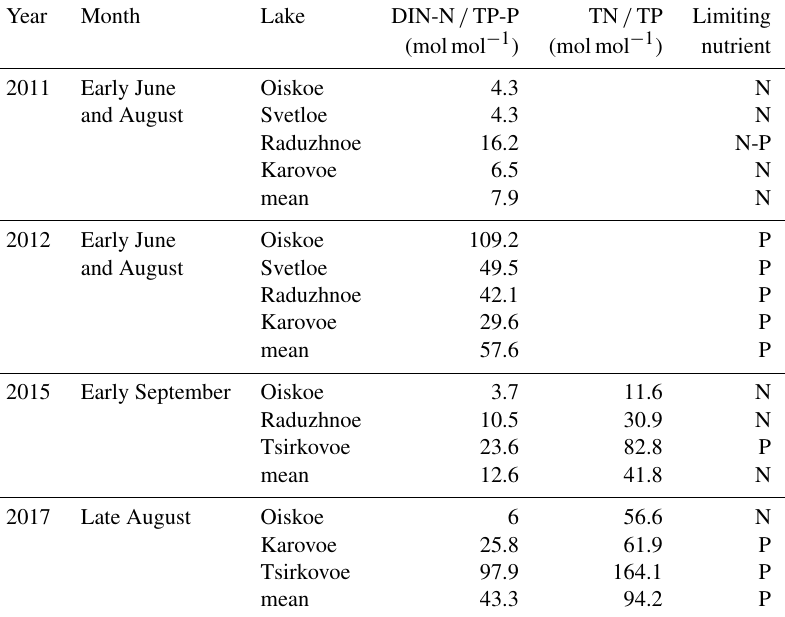
Table 3. Lake water N:P ratios along the studied years and limiting nutrients according to nutrient availability (DIN-N / TP-P) and the Redfield ratio. Year Month Lake DIN-N / TP-P TN / TP Limiting (molmol − 1 ) (molmol − 1 ) nutrient 2011 Early June Oiskoe 4.3 N and August Svetloe